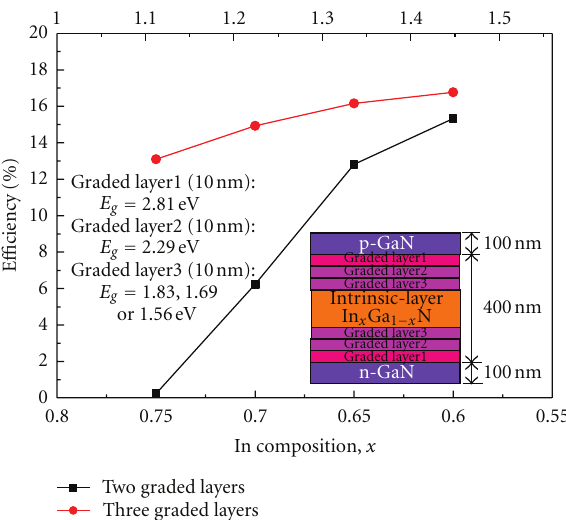
Figure 9: The e ffi ciency of three graded-layer pin solar cells as a function of the In composition from 0.6 to